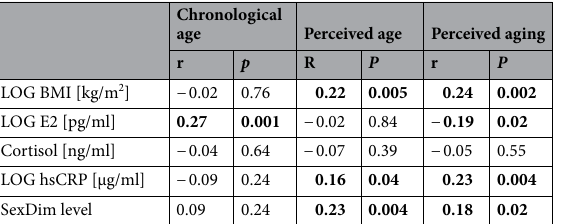
Table 6. Correlation between chronological age, perceived age, and aging and controlled variables in women (N = 163). Significant values are in